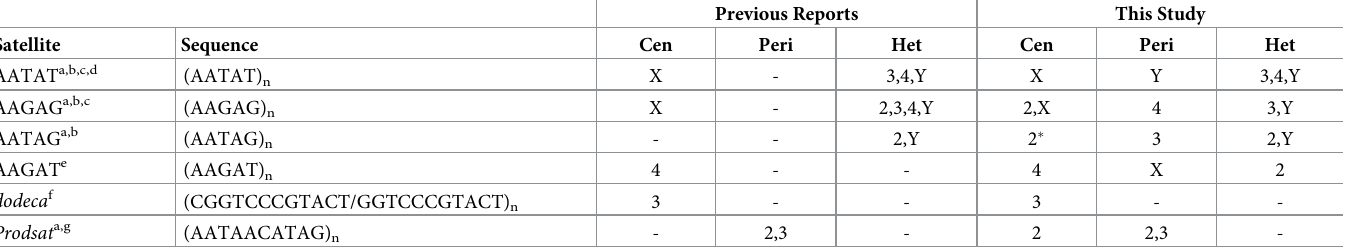
Table 1. Location of centromeric and centromere-proximal satellites in D . melanogaster . Locations of satellites on chromosomes X, Y, 2, 3, and 4 according to previous reports and our observations in this report by IF-FISH in the D . melanogaster sequenced strain iso-1. Each satellite location is characterized as being centromeric (overlaps with CENP-C), pericentric (juxtaposed to CENP-C), or heterochromatic (more distal than pericentric). Note that the dodeca satellite includes its variants and that Prodsat is also known as the 10-bp